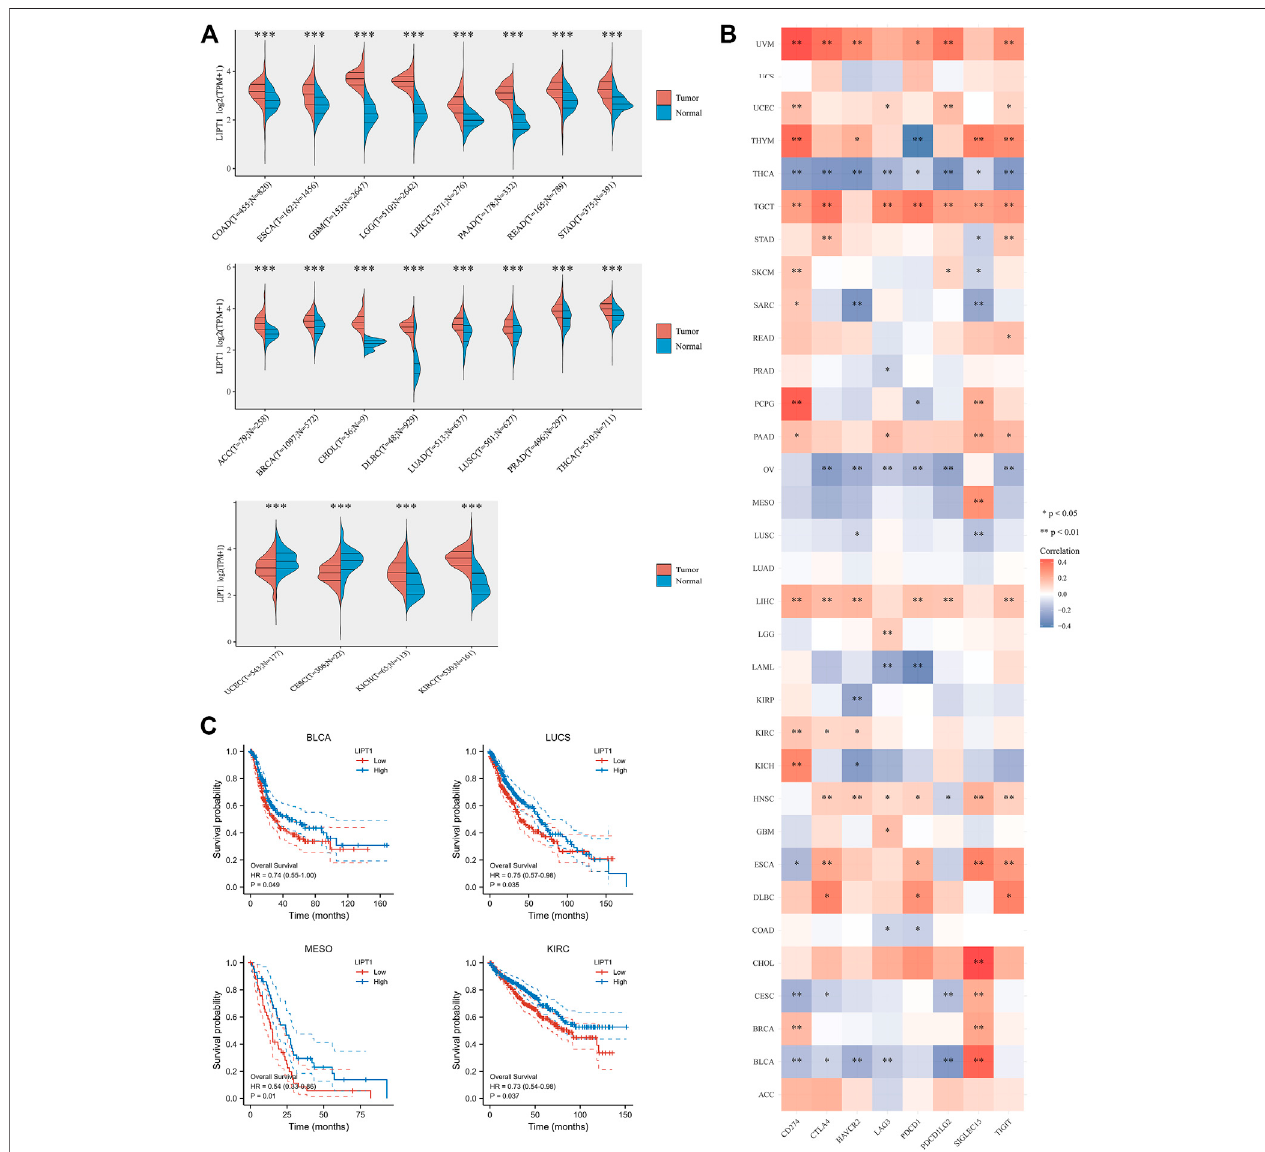
FIGURE 6 | Comprehensive analysis of LIPT1 in pan-cancers. (A) LIPT1 was differentially expressed in most cancer types. (C) Highly expressed LIPT1 showed goodoverallsurvivalinmultiplecancers. (B) TherelationshipbetweenexpressionofLIPT1andeightcommonimmunecheckpointsinpan-cancers.* p < 0.05,** p < 0.01, and *** p <